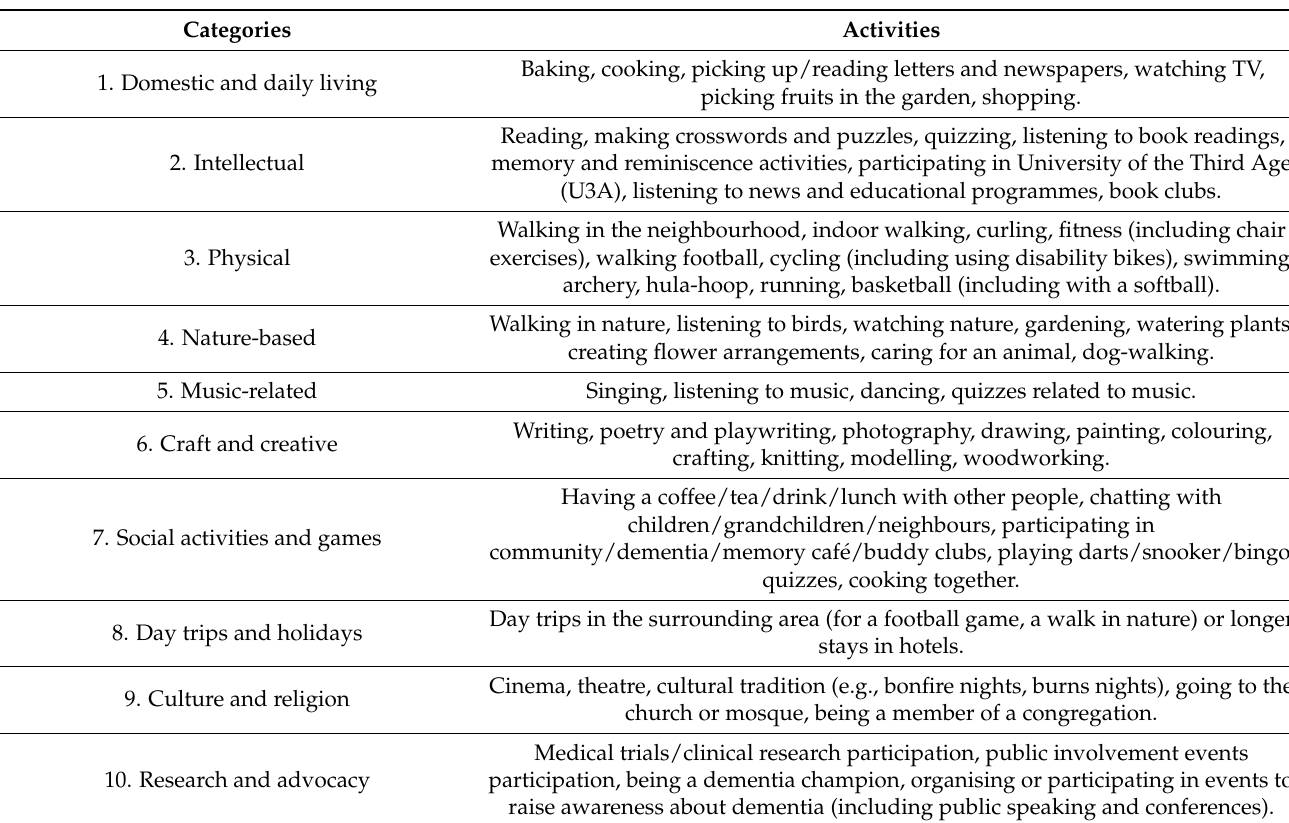
Table 4. Self-reported favourite